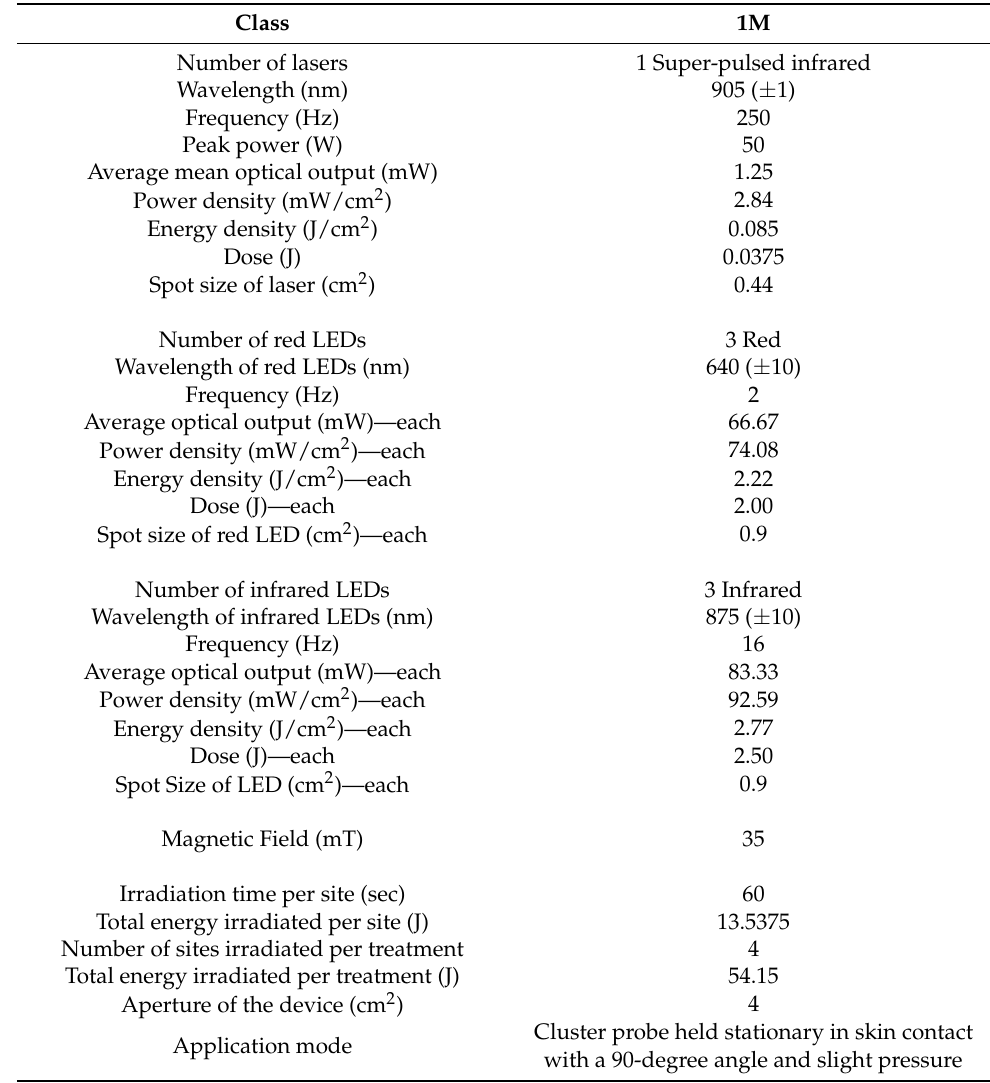
Table 1. Parameters for Activ Pro ®